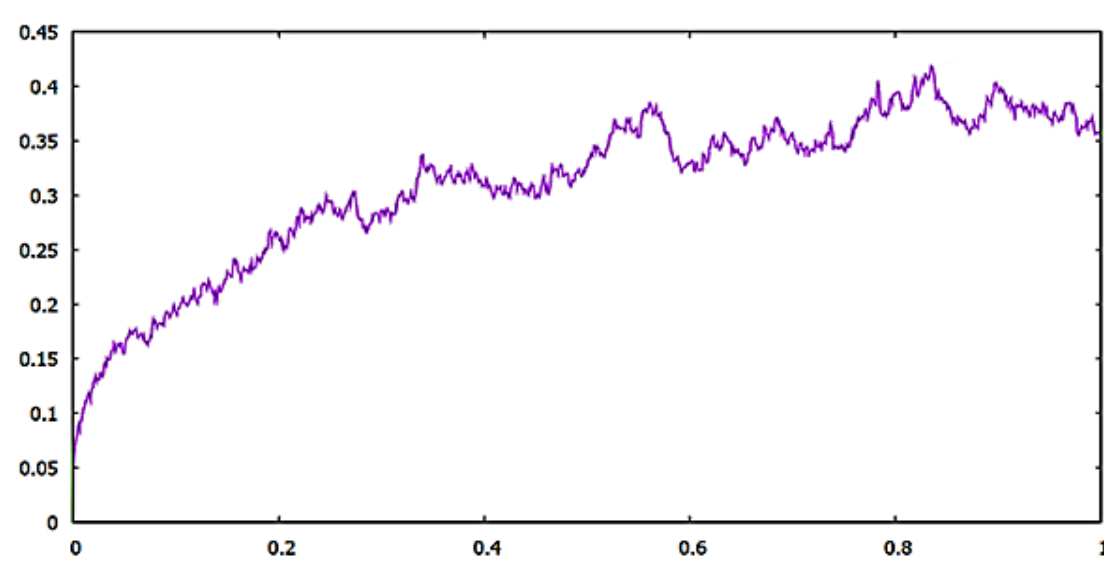
FIGURE 5 - RMSD plot of DENV4-NS1 at